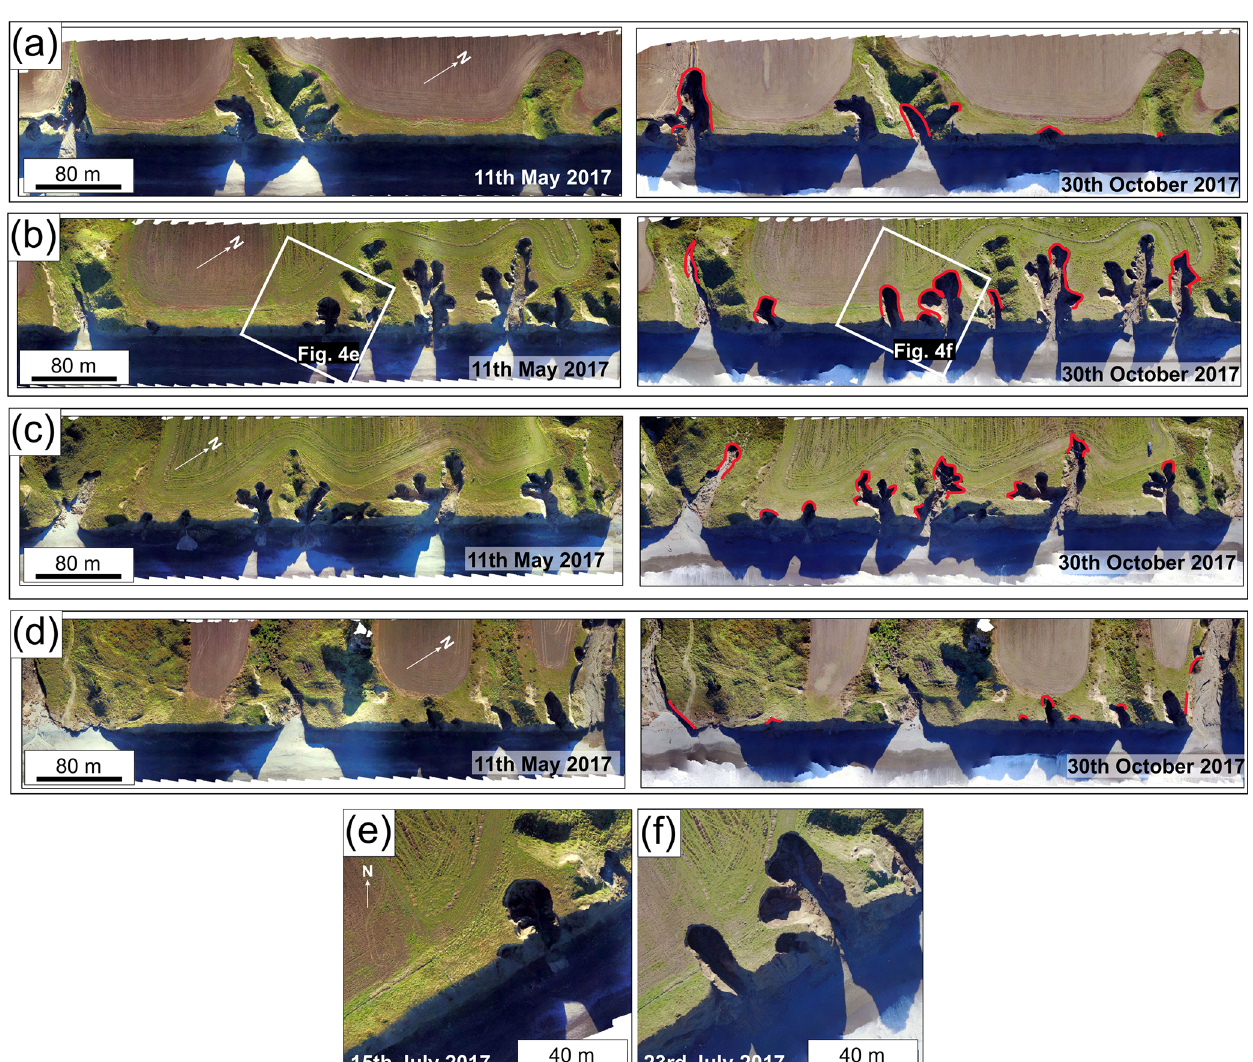
Figure 4. (a–d) Orthophotographs of the study area at the start and end of the UAV surveys, ordered from southwest to northeast. Red lines mark eroded areas. Location shown in Fig. 1b. Orthophotographs from a part of the study area on (e) 15 July 2017 and (f) 23 July 2017. Location shown in (b)